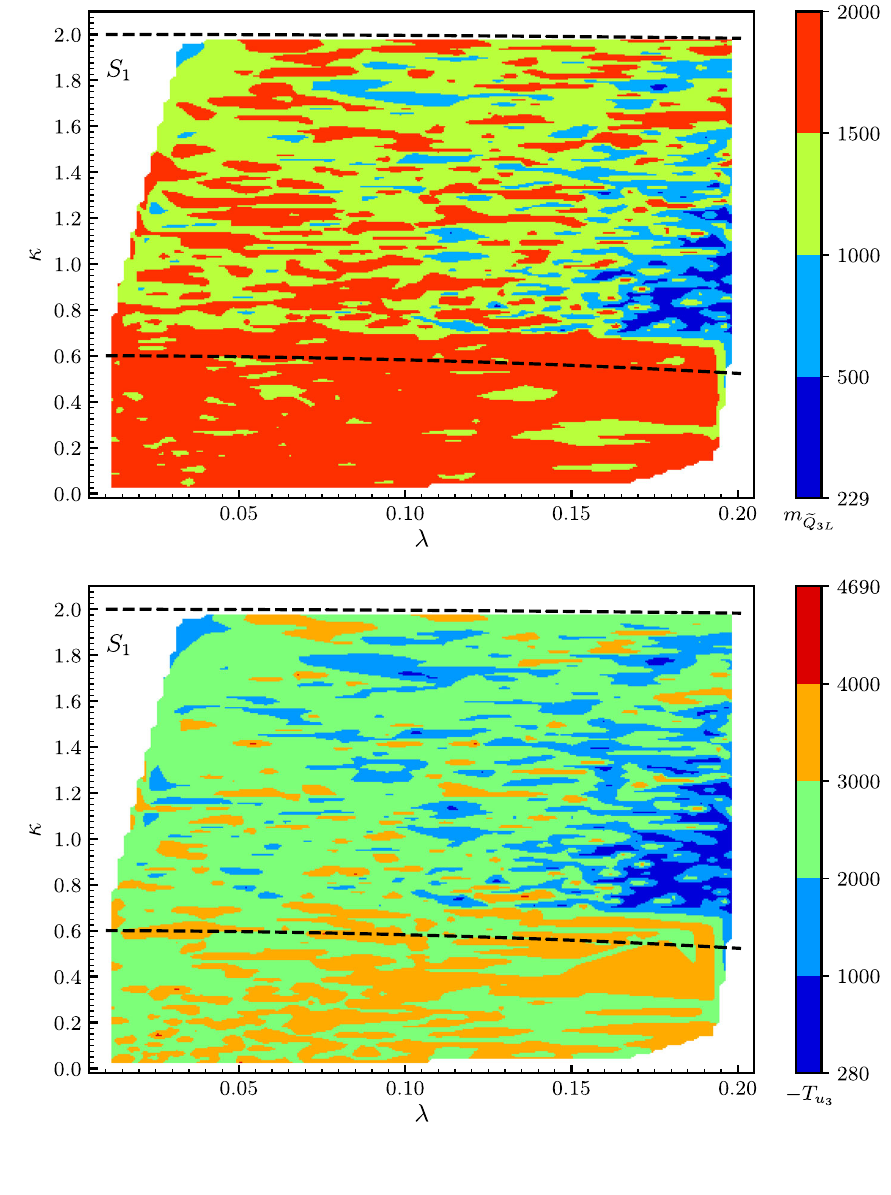
Fig. 20 The same as in Fig. 16, but the colours indicate different low-energy values of the soft masses m (cid:6) Q 3 L